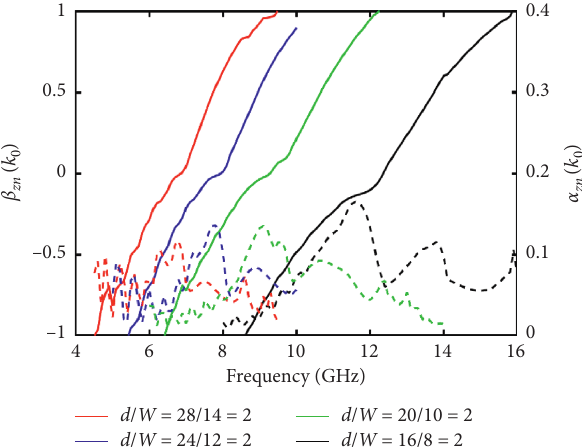
Figure 9: The normalized propagation constant of different pa- rameters when d / W �